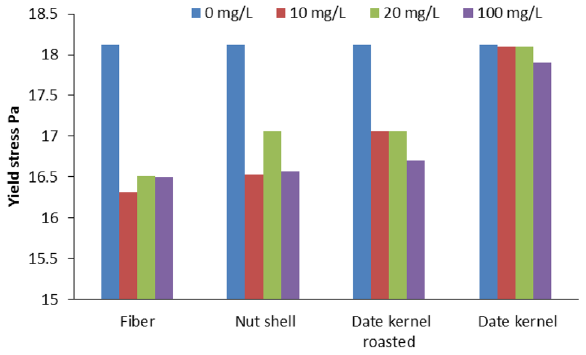
Fig. 15 Yield stress of heavy crude oil with150 µm bio materials